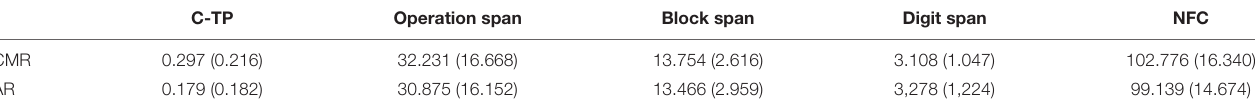
TABLE 1 | Descriptive statistics for the continuous